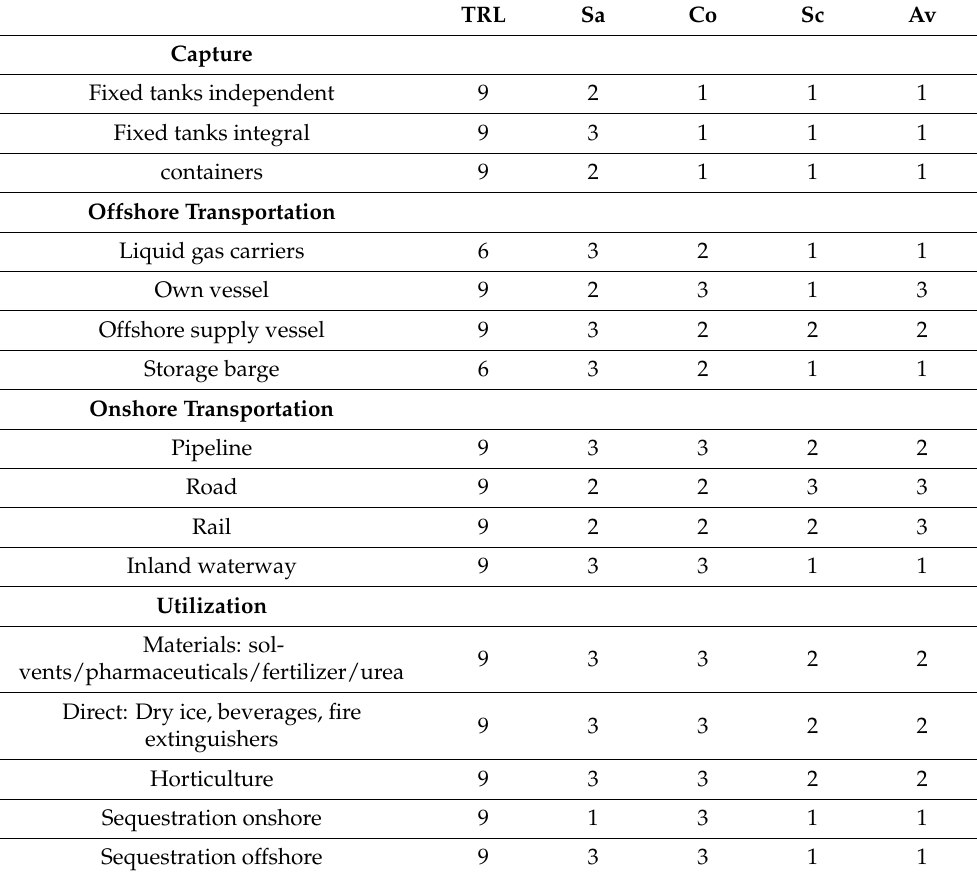
Table 1. Technical feasibility of the supply chain of ship-based carbon